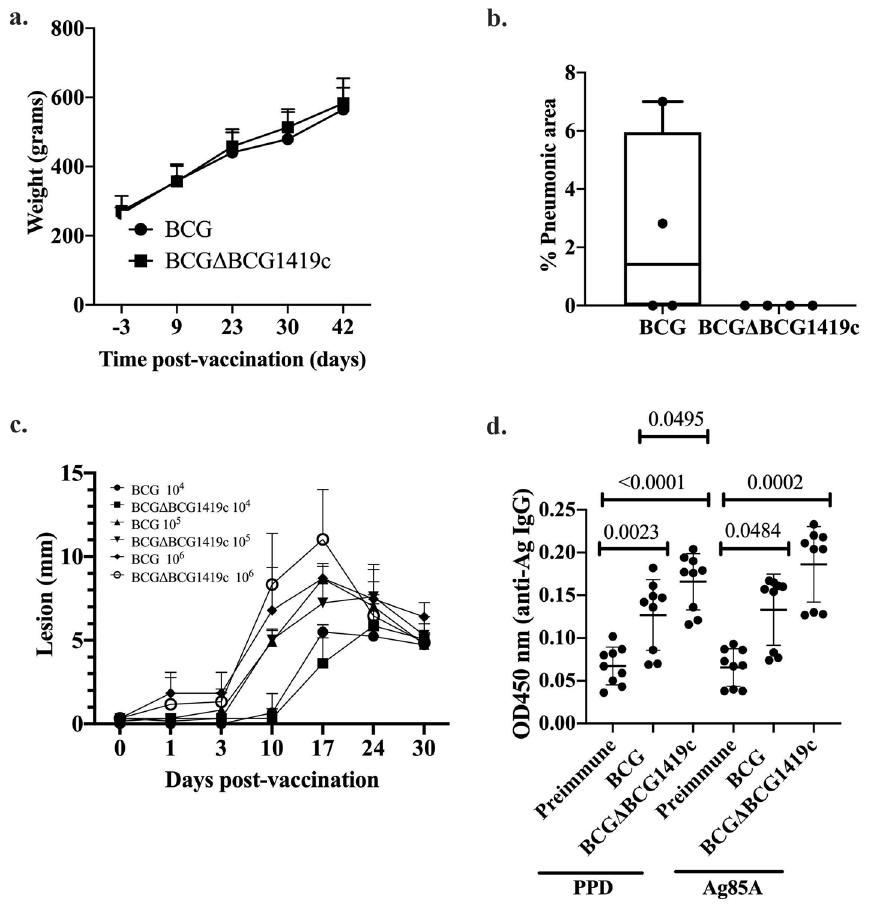
Figure 3. The BCGΔBCG1419c vaccine candidate is as safe as parental BCG and induces more anti-PPD IgG. ( a ) Body weight registry of guinea pigs (n = 6/group) after intramuscular (i.m.) vaccination with 10 7 CFU of BCG or BCGΔBCG1419c over 42 days. Data is presented as means with SD and were evaluated with multiple t tests corrected for multiple comparison with Holm–Sidak method at α = 0.05. ( b ) Histopathological assessment of pneumonic areas found at 42 days post-vaccination (i.m.) in guinea pigs (n = 4/group) that received 10 7 CFU of BCG or BCGΔBCG1419c. Data is presented as a box and whisker plot showing all points. ( c ) Excessive dermal reactivity in guinea pigs (n = 6/group). Each guinea pig was intradermally injected with three different doses of BCG or BCGΔBCG1419c. Lesions formed at the sites of injection were observed over a 28-day period. In each animal, the papule sizes resulting from vaccination with either BCG strain were compared with a multiple t test corrected for multiple comparison with Holm–Sidak method at α = 0.05. Data are presented as mean with SD. ( d ) Anti-IgG reactivity to bovine PPD and recombinant Ag85A from guinea pigs (n = 9/group) pre-vaccination (preimmune) and 10 weeks post-vaccination with 10 3 CFU of BCG or BCGΔBCG1419c. Data are presented as mean with SD with individual OD450nm values shown. A One-Way ANOVA followed by Tukey’s multiple comparison test or a Kruskal–Wallis followed by Dunn’s multiple comparison test were used depending on distribution of data, and significantly different p values are